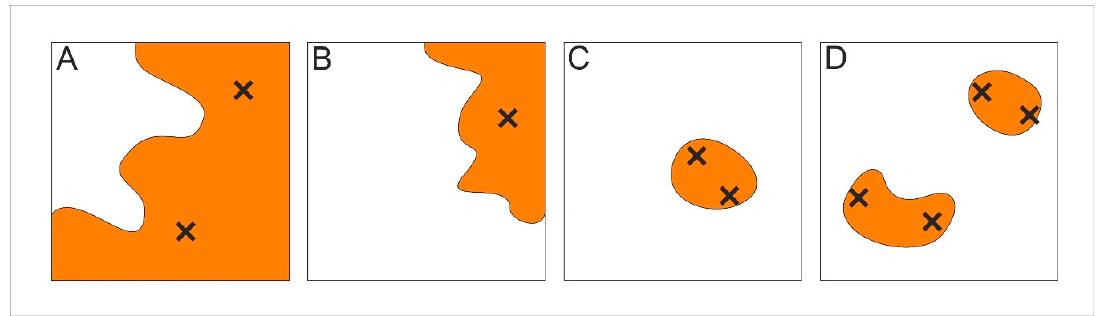
Figure 11. Illustration of the sampling strategy. ( A ), ( B ), ( C ), and ( D ) represent examples of the possible situations in the 1 × 1 m quadrants. The orange fields of irregular shape represent S. brachyodon patches, while the “x” marks symbolize the sampled ramets.